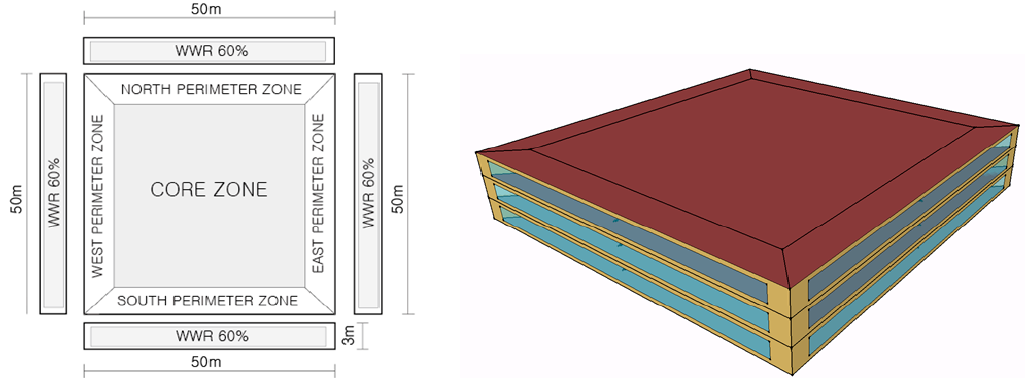
Figure 5. Analysis model plan (left) and EnergyPlus 8.5 simulation analysis model (right).